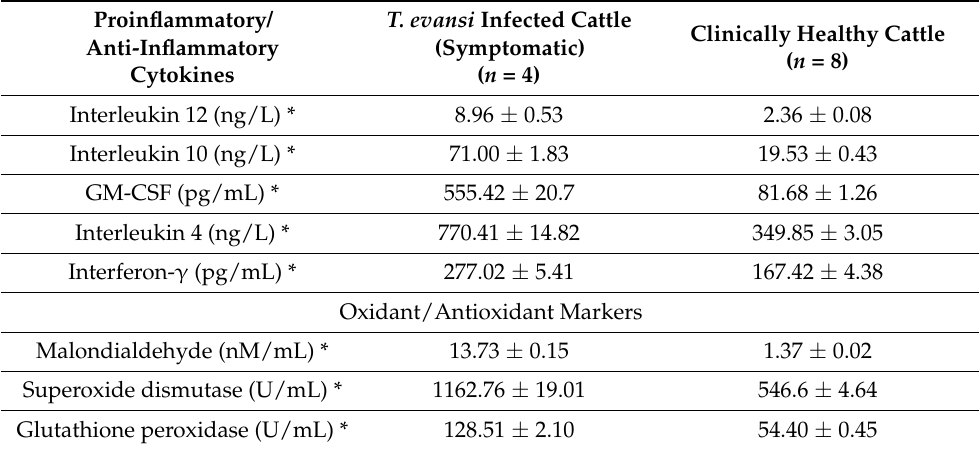
Table 7. The serum inflammatory cytokines and oxidant/antioxidant levels in symptomatic and asymptomatic cattle naturally infected with Trypanosoma evansi